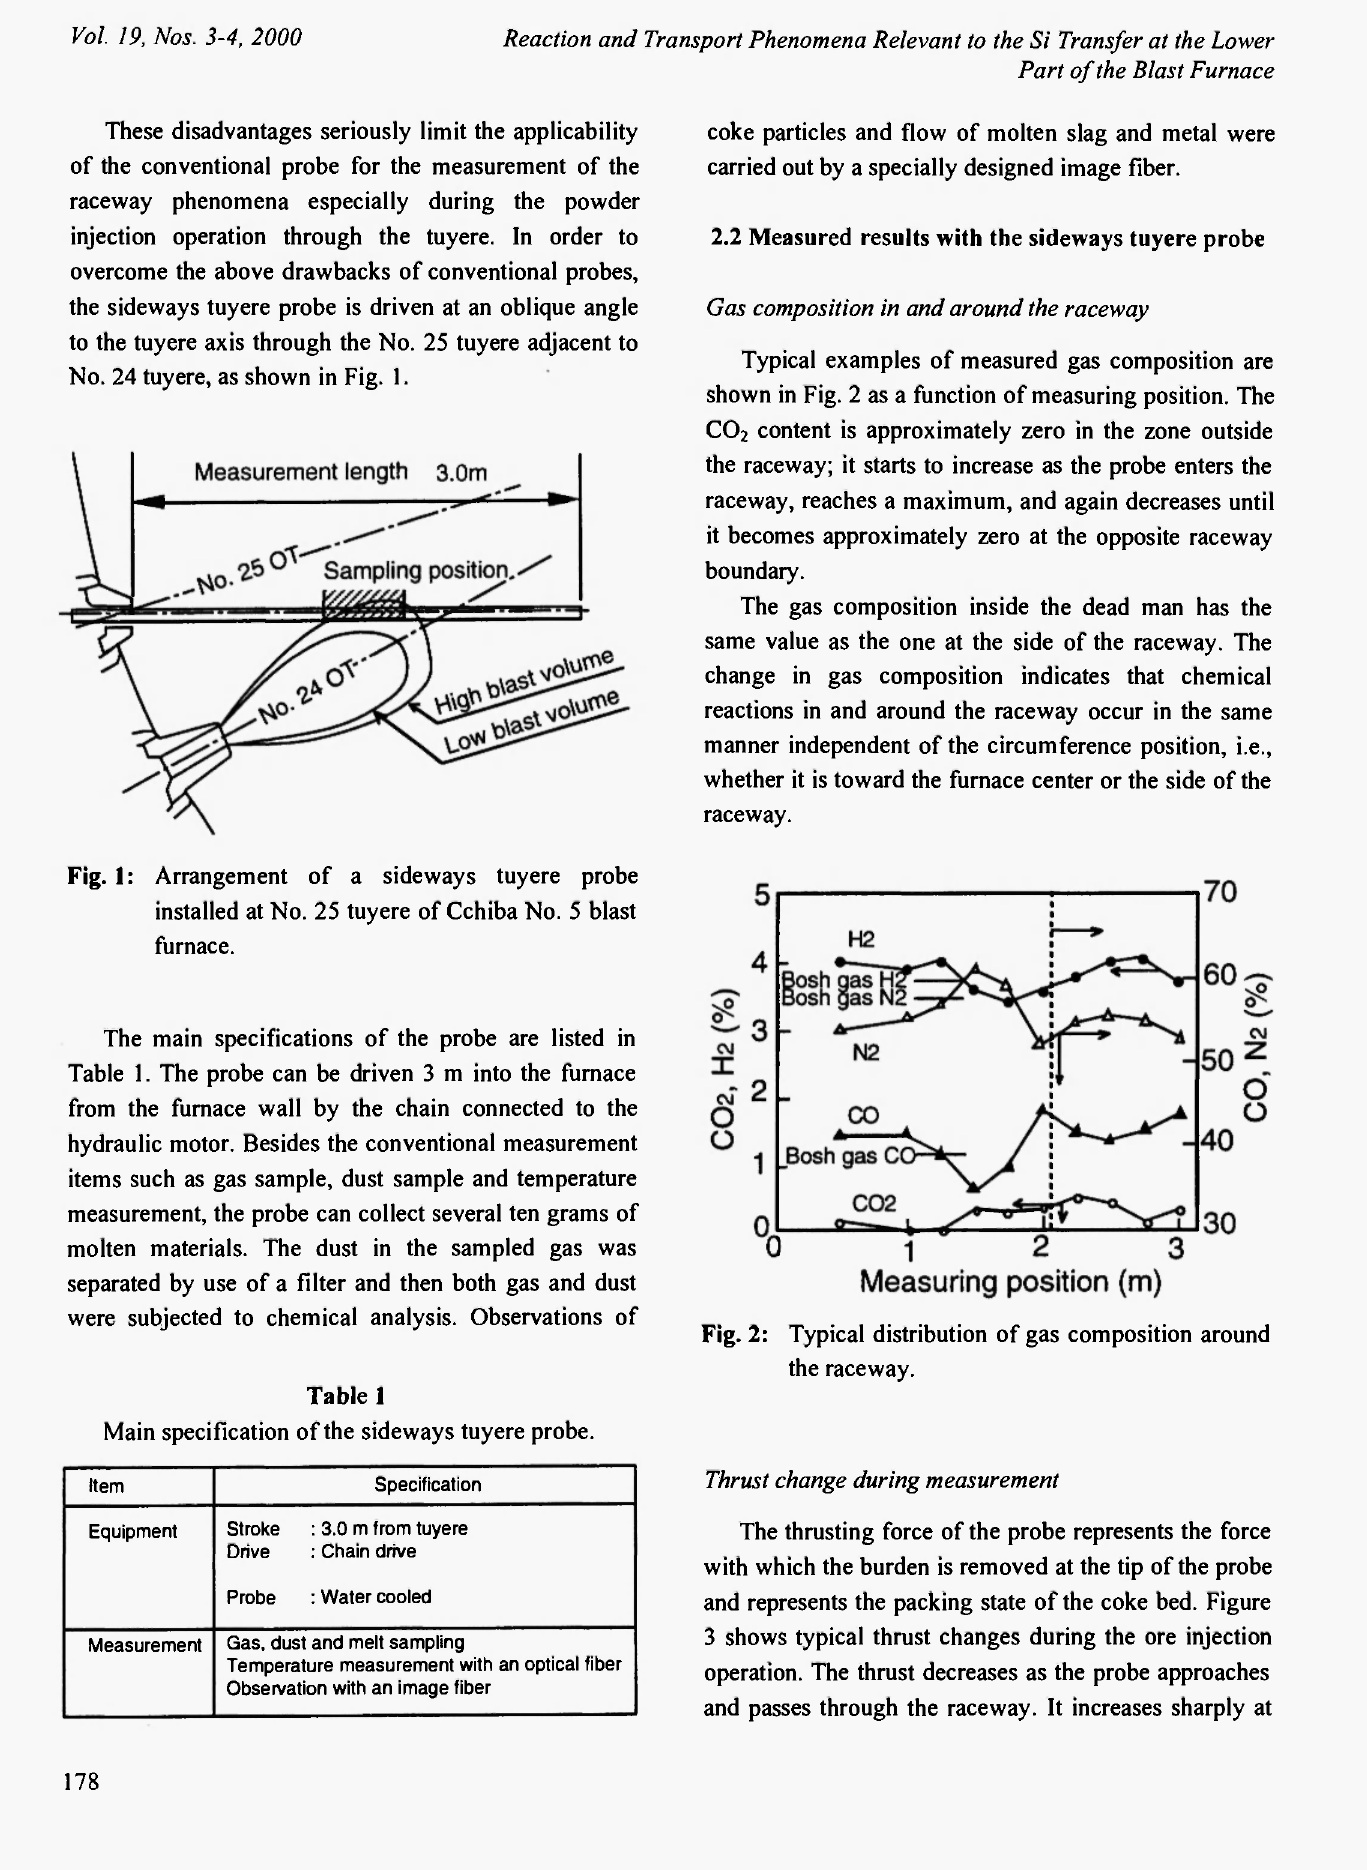
Fig. 2: Typical distribution of gas composition around the raceway.